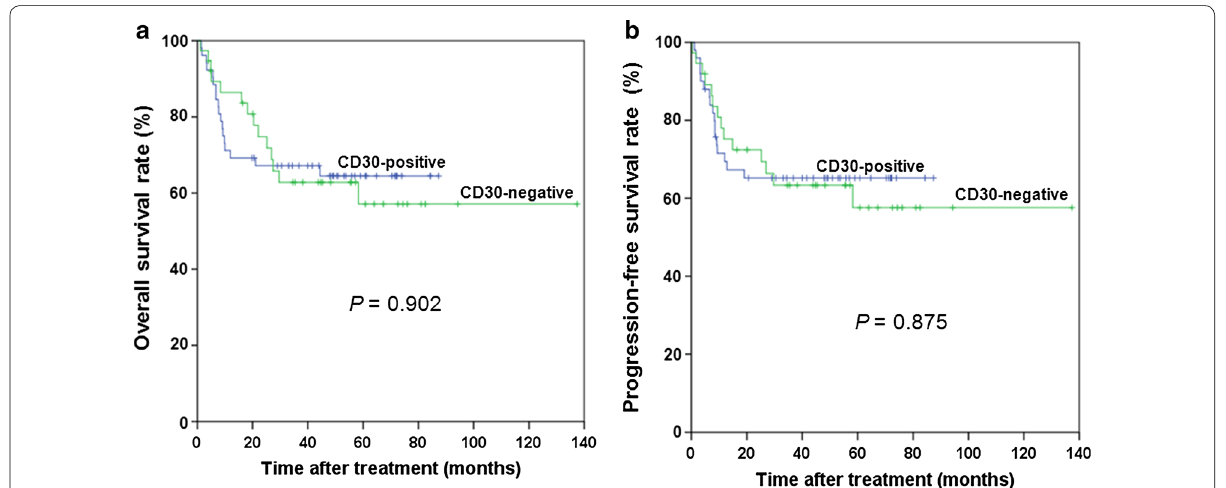
Fig. 3 Survival curves of 91 patients with ENKTL as stratified by CD30 expression. a Overall survival; b Progression-free